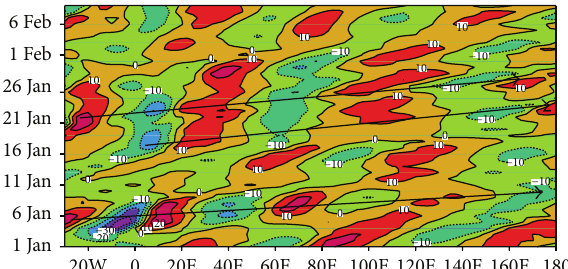
Figure 6: Time-longitude cross section of the 300 hPa meridional wind, averaged over 20–40 ∘ N, from January 1 to February 10, 2008.